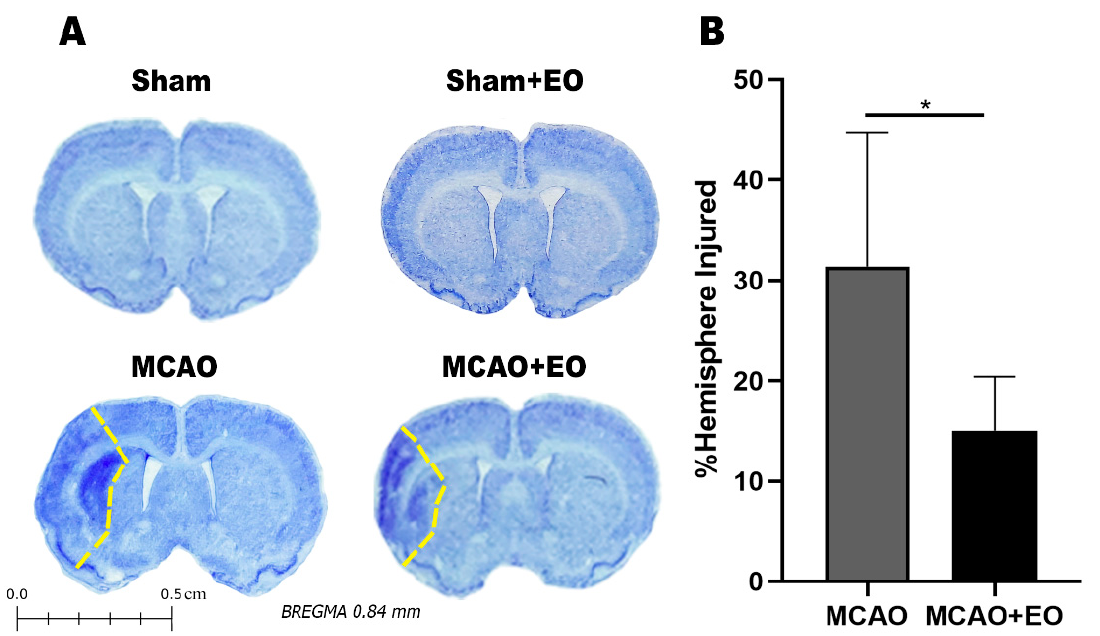
Figure 3. Injured area and percentage of cerebral infarction of animals submitted to middle cerebral artery occlusion (MCAO) and treated with clarified Euterpe oleracea extract: ( A ) Representative image of an injured hemisphere; ( B ) Mean percentage of injury in the cerebral hemisphere. The data are expressed as the mean ± SD ( n = 6 animals per group; Student’s t test; * p < 0.05).